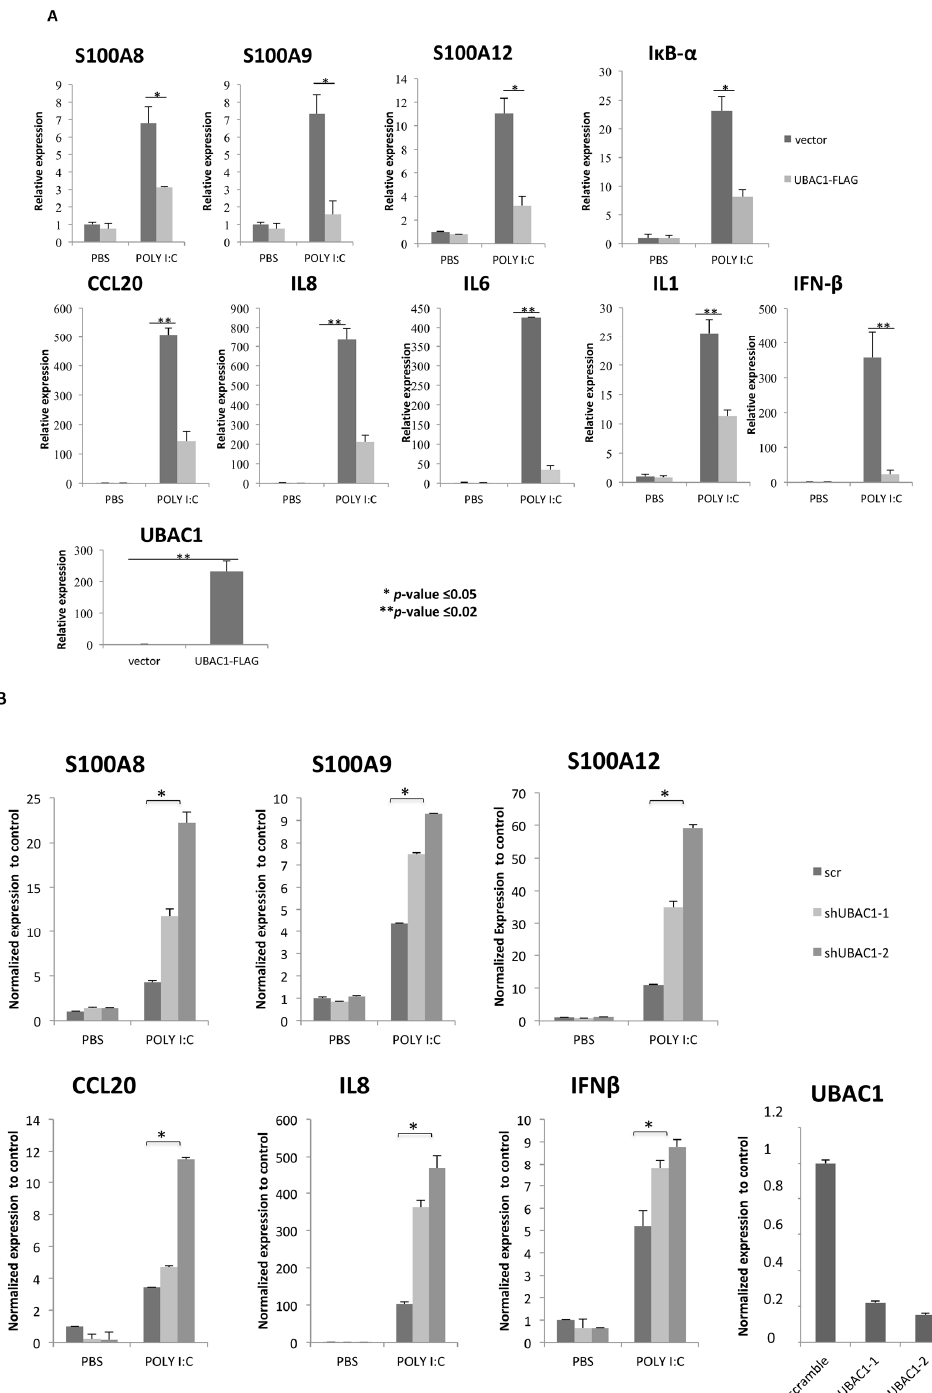
Figure 2. UBAC1 represses TLR3 signaling. ( A ) NHEK cells were infected with a lentiviral vector expressing UBAC1 or control GFP. A total of 48 h later, cells were left in PBS or exposed poly (I:C) (20 µ g / mL) for 24 h, and the expression level of selected NF- κ B and IRF3 target genes was monitored by real time PCR. Graphs show the fold-change with respect to the cells left in PBS. Data shown are representative of five independent experiments done in triplicate. Data were analyzed by Student’s t -test (* p -value ≤ 0.05; ** p -value ≤ 0.02). ( B ) NHEK cells were infected with retroviral vectors encoding for two di ff erent shRNAs targeting UBAC1 or a control shRNA (scramble). After selection, cells were left in PBS or exposed to poly (I:C) (20 µ g / mL) for 24 h, and the expression level of selected NF- κ B target genes were quantified by real-time